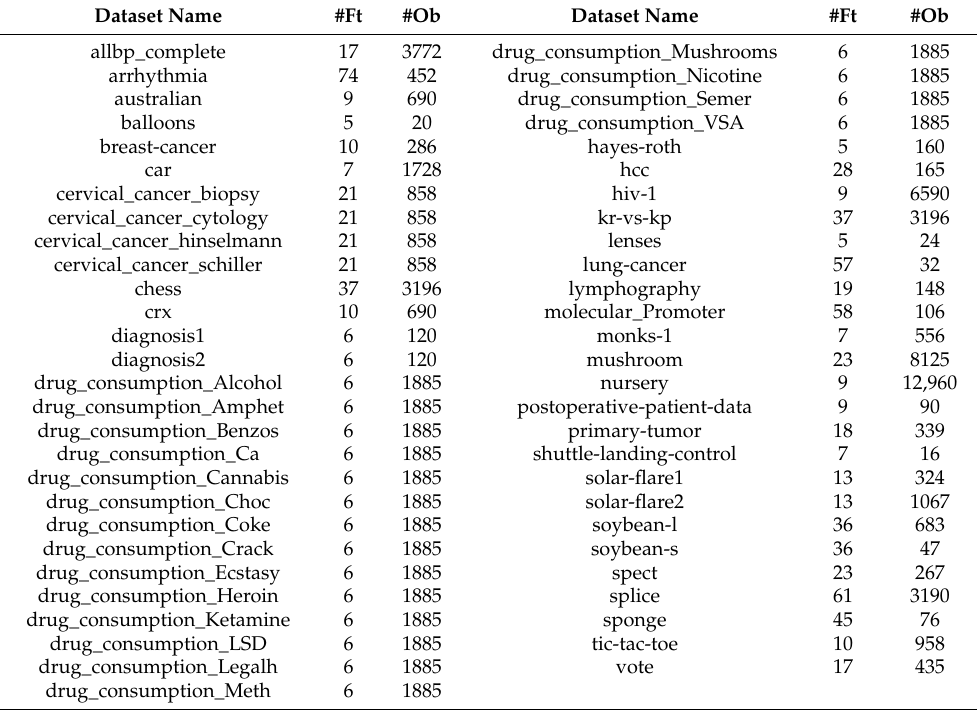
Table 4. Datasets, as well as some characteristics thereof, used in our experimentation. They were all taken from the UCI Machine Learning Repository [11] . Columns #Ob and #Ft, respectively, stand for number of objects and number of categorical